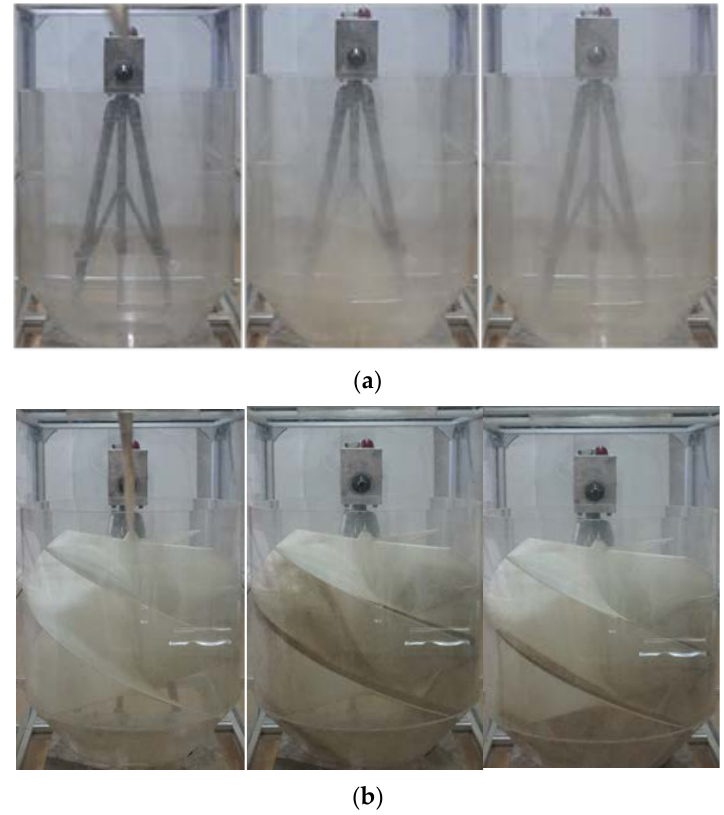
Figure 9. Dust emissions situation of ( a ) conventional hopper and ( b ) spiral hopper.